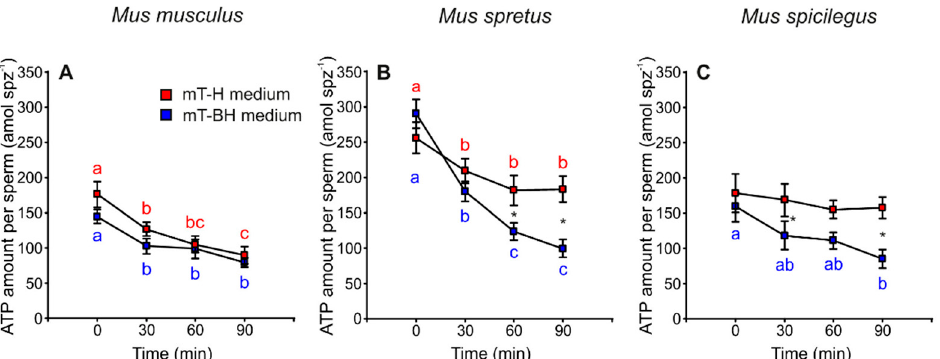
Figure 5. Variation in ATP amount per sperm in three mouse species ( M. musculus , M. spretus , M. spicilegus ) incubated under non-capacitating conditions (mT-H medium) and capacitating conditions (mT-BH medium). Data are means ± SE ( n = 7 in M. musculus , n = 8 in M. spretus , and n = 6 in M. spicilegus ). Red squares: non-capacitating conditions, mT-H medium under air. Blue squares: capacitating conditions mT-BH medium under 5% CO 2 /air. ( A – C ) ATP amount per sperm (amol spz − 1 ). ( A ) M. musculus . ( B ) M. spretus . ( C ) M. spicilegus . Asterisks indicate significant differences ( p < 0.05) between treatments for the same time in a Fisher post-hoc test. Different letters between times of incubation for the same treatment indicate statistically significant differences ( p < 0.05) in a Fisher post-hoc test. If two time-points of an incubation share any letter, the differences between them are not significant. No letters were used when a time-point of an incubation did not show any significant effect in the dependent variable.